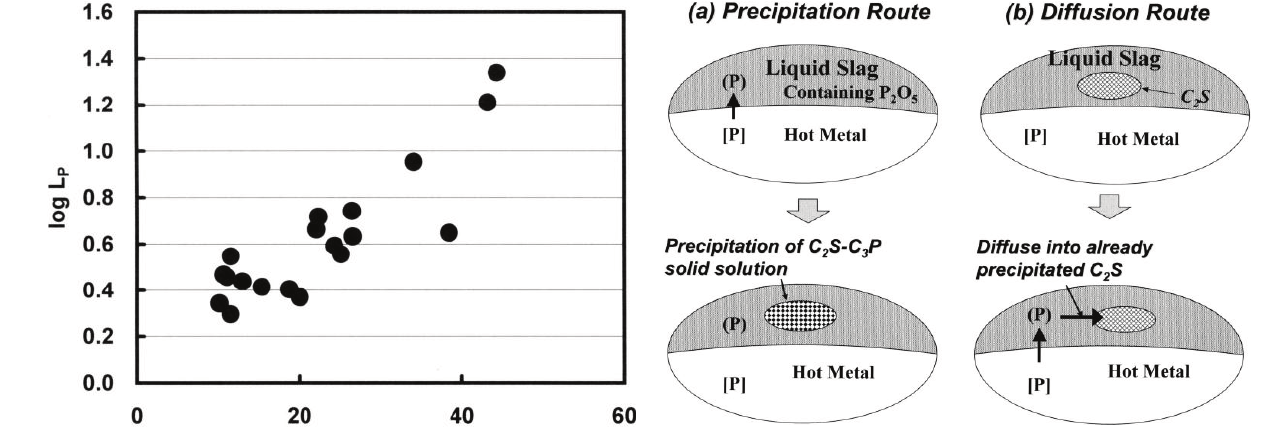
Figure 3. Two mechanisms for enriching phosphorus from the liquid slag to solid solution.